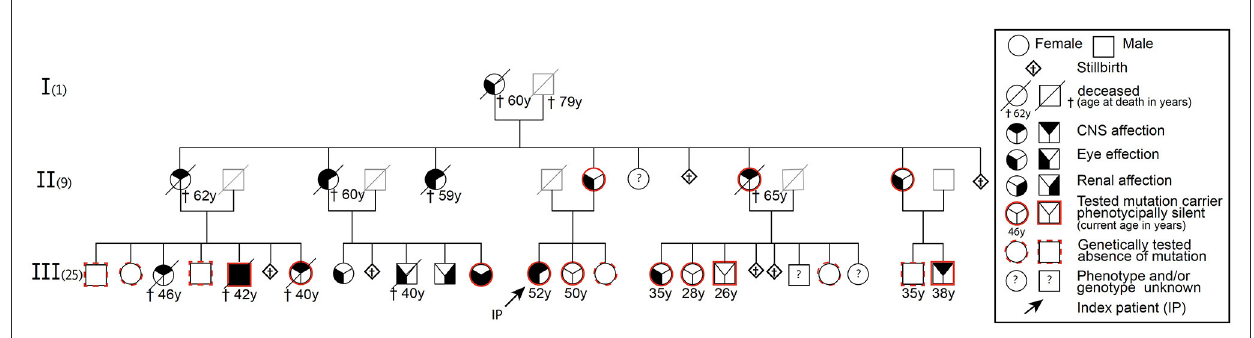
FIGURE1 Pedigree of a family with autosomal dominant mutation in the C-terminal sequence of the TREX1 gene (pVAL235Glyfs * 6) leading to